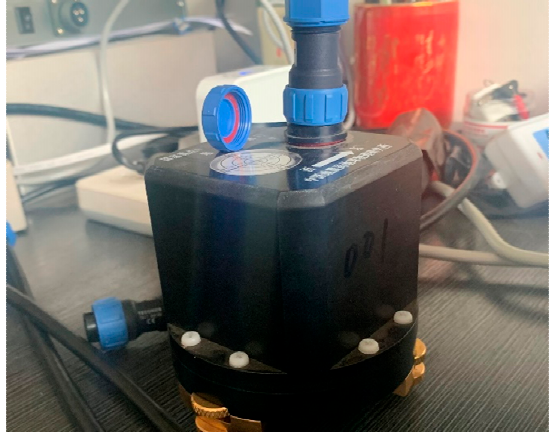
Figure 7. Photo of the fluxgate sensor.